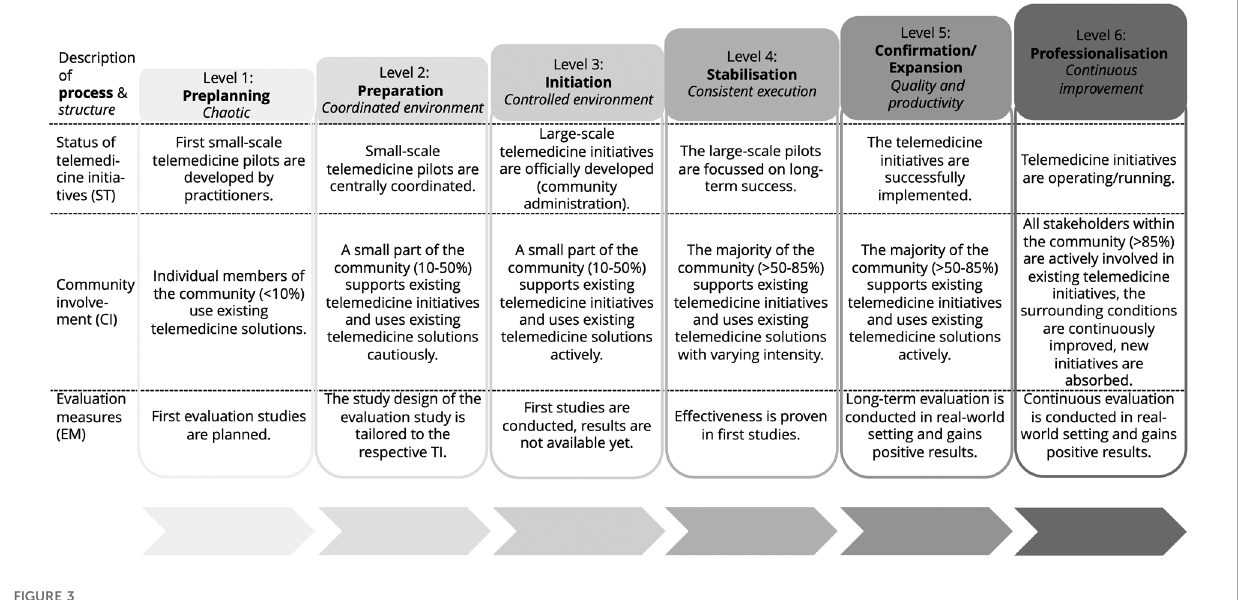
FIGURE 3 The assessment part of the TCRM.